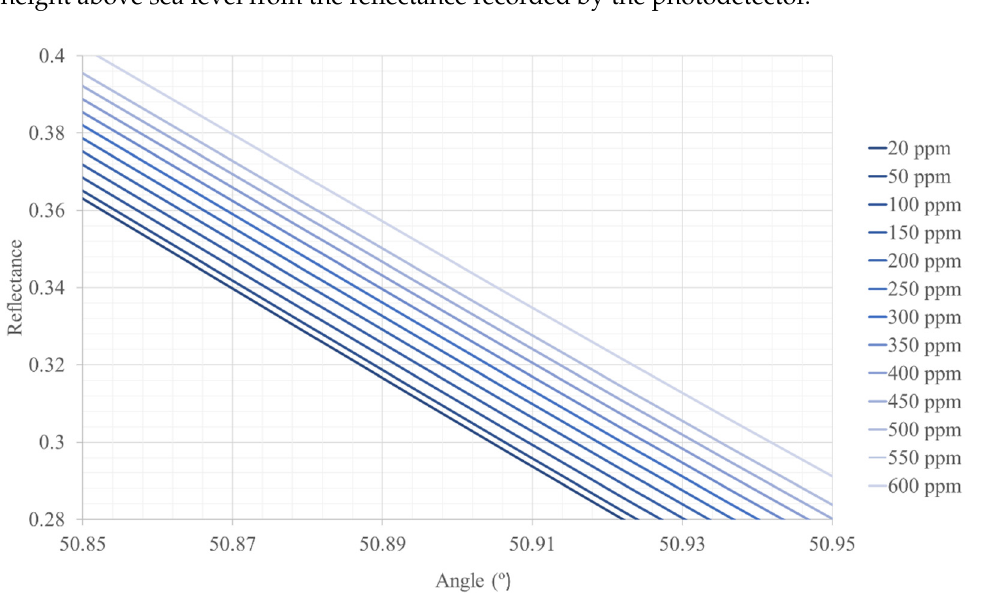
Figure 2. Reflectance curves as a function of the angle of incidence of the light in the hemispherical prism and different concentrations of CO. The height above sea level is 0 m, 101,325 Pa, 25 °C. The sensor works with an incidence angle of 50.91°.